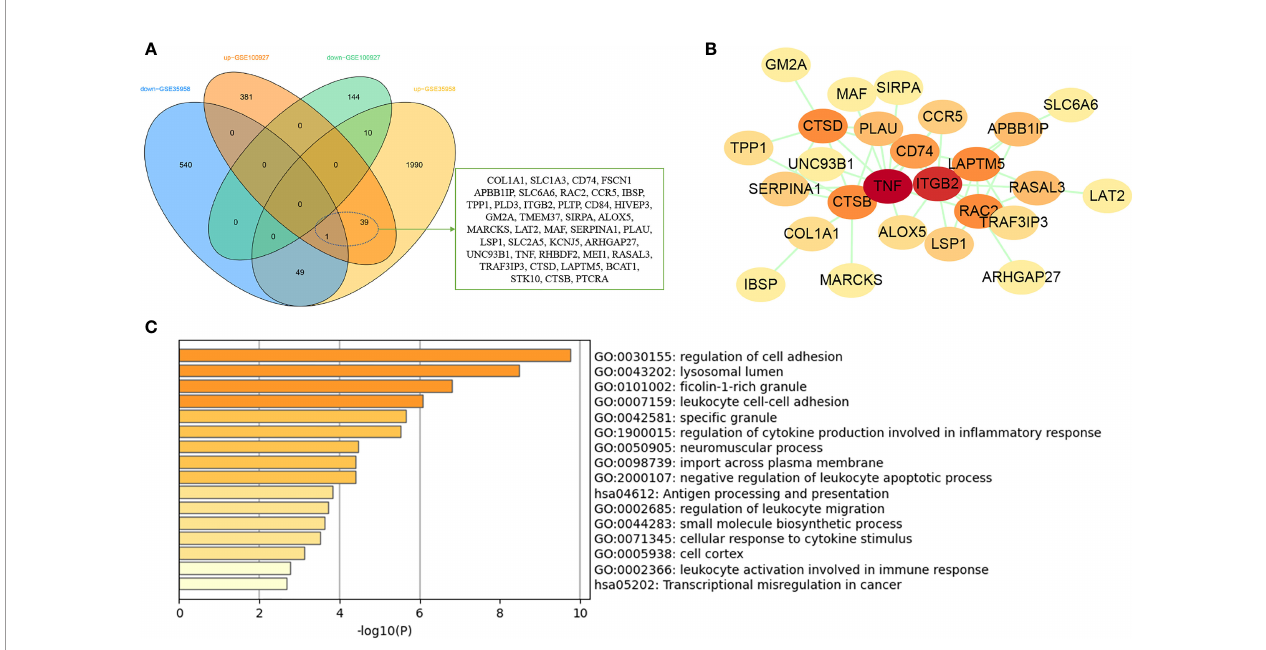
FIGURE 5 | Analysis of common DEGs between osteoporosis and atherosclerosis. (A) The Venn diagram of the common DEGs in GSE35958 and GSE100927. (B) The PPI network of the common DEGs. (C) GO and KEGG enrichment analysis of the common